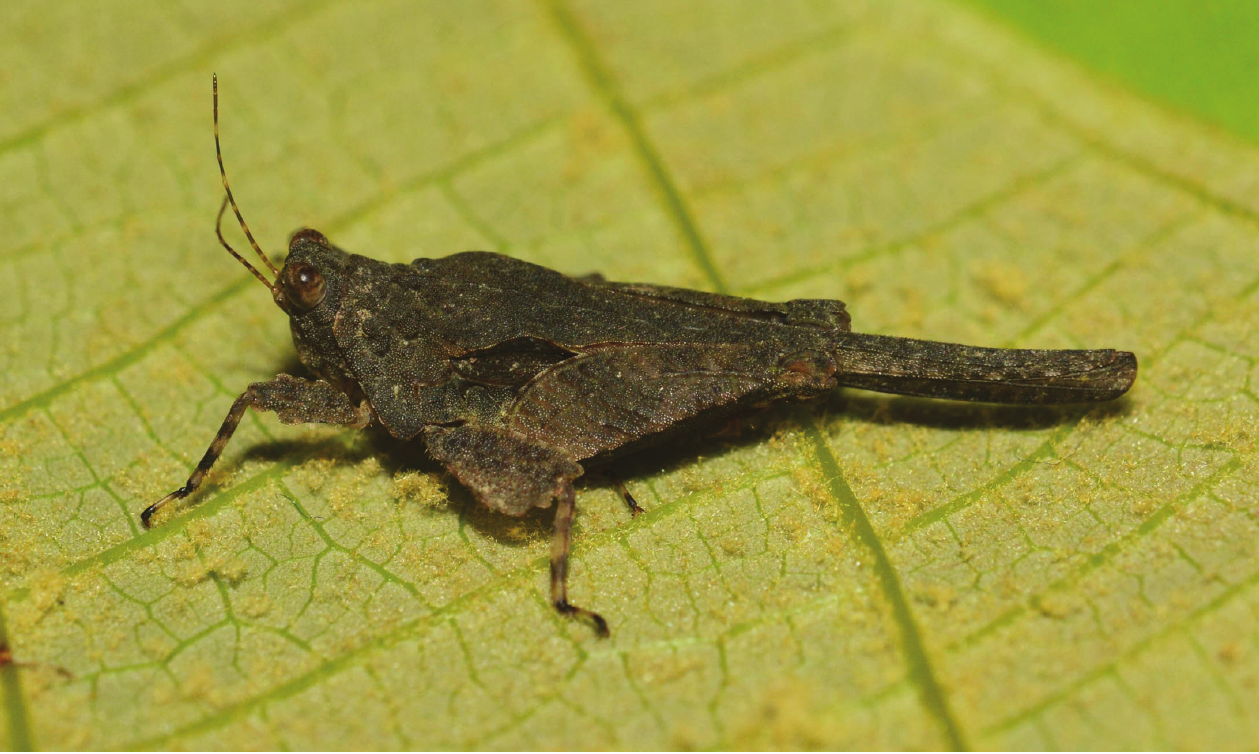
visible and hidden behind the femur. Abdomen. (Fig. 4A, B). Ster- nites not visible due to specimen glued on card; ovipositor valves short and robust, superior margin of dorsal and ventral valve with teeth. Measurements (in Hancock, 1907). Total length of female body: 16.5 mm; pronotum: 14.5 mm; hind femur: 7 mm. Male (paralectotype, Fig. 5).— Similar to female, except: Head . Fron- tal view (Fig. 5D). Fastigium straight. Pronotum . Lateral view (Fig. 5A, B). Humero-apical carina not continuous to external lateral carina. Measurements (in Hancock 1907). Total length of male body: 15 mm; pronotum: 13 mm; hind femur: 6 mm. Measurements (from additional specimens studied; in mm).—